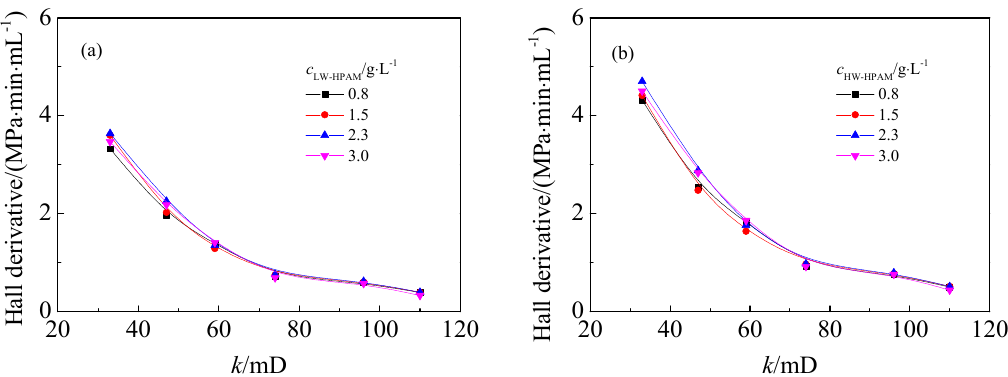
Figure 17. Variation of the Hall derivative of ( a ) LW-HPAM/ANS and ( b ) HW-HPAM/ANS with core permeability at different polymer concentrations. c ANS = 3.0 g ⋅ L − 1 .